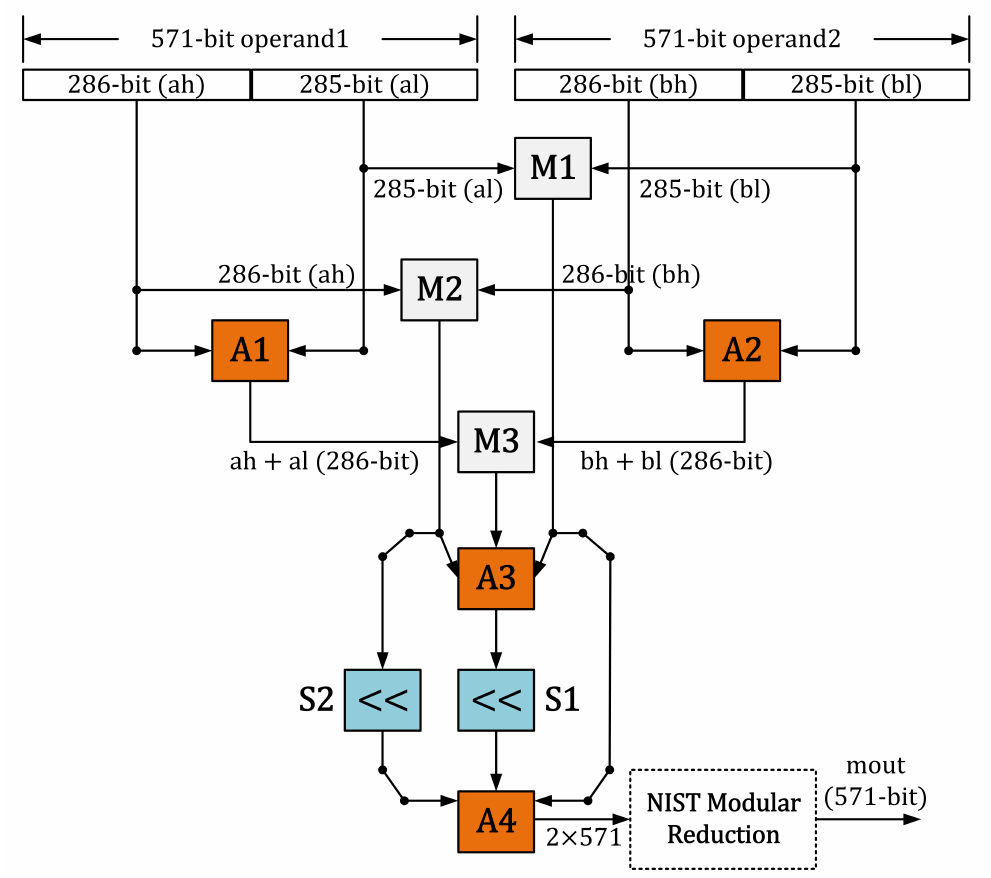
Figure 2. Proposed Karatsuba modular multiplier.